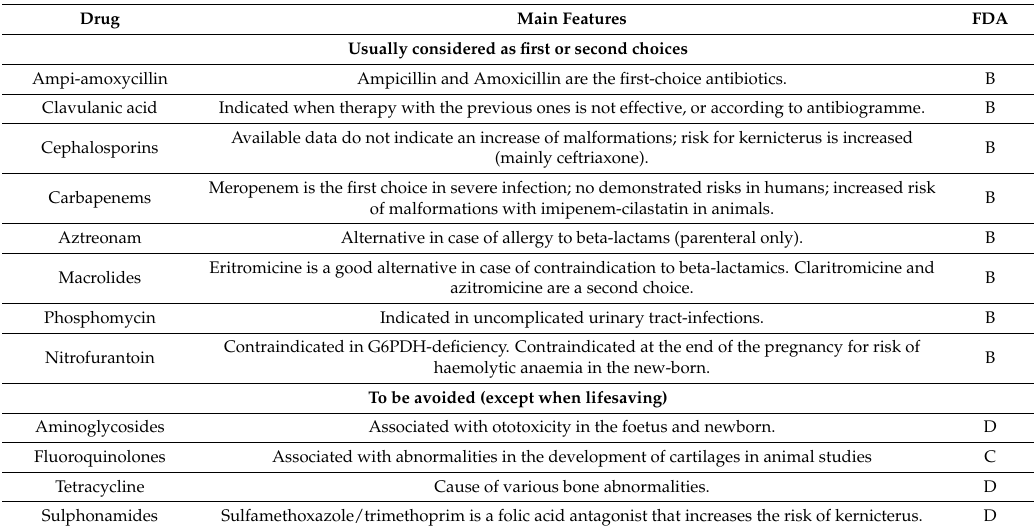
Table A3. Main antibiotics for CKD patients in pregnancy.